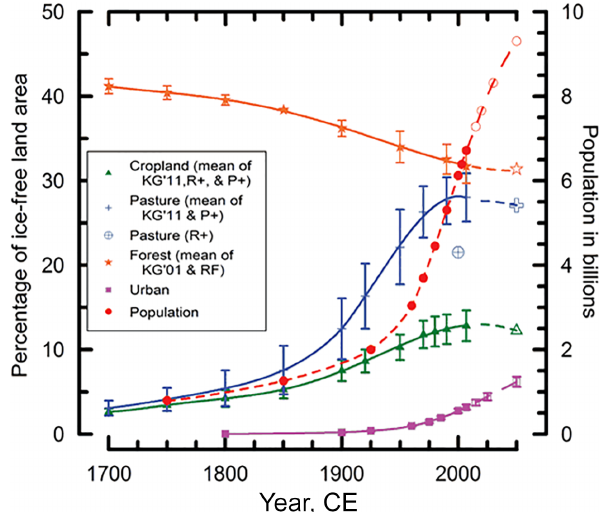
Figure 2. Adapted from Hooke and Martin-Duque (2012). Changes in land use through time (closed symbols) with extrapolations to 2050CE (open